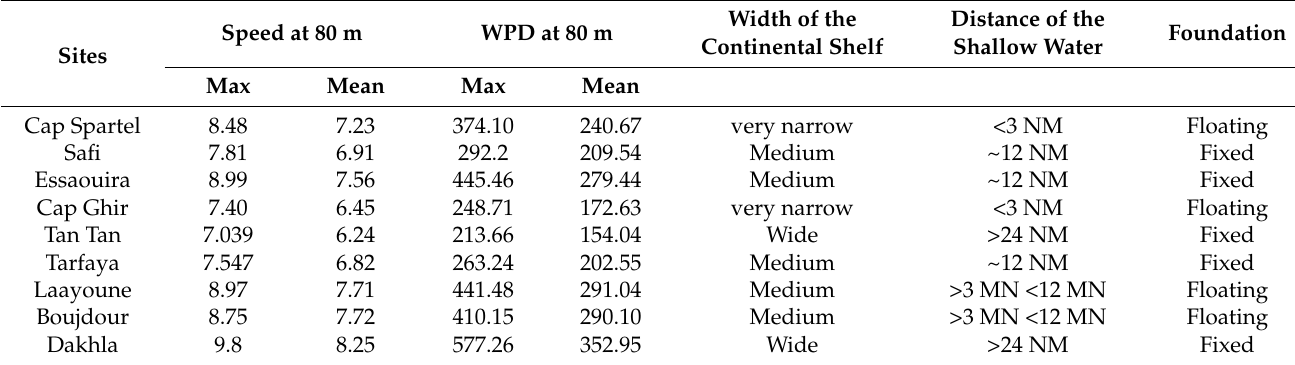
Table 3. Synthetic table of the likely technologies to be deployed for each site off Morocco according to the topographic features of the continental